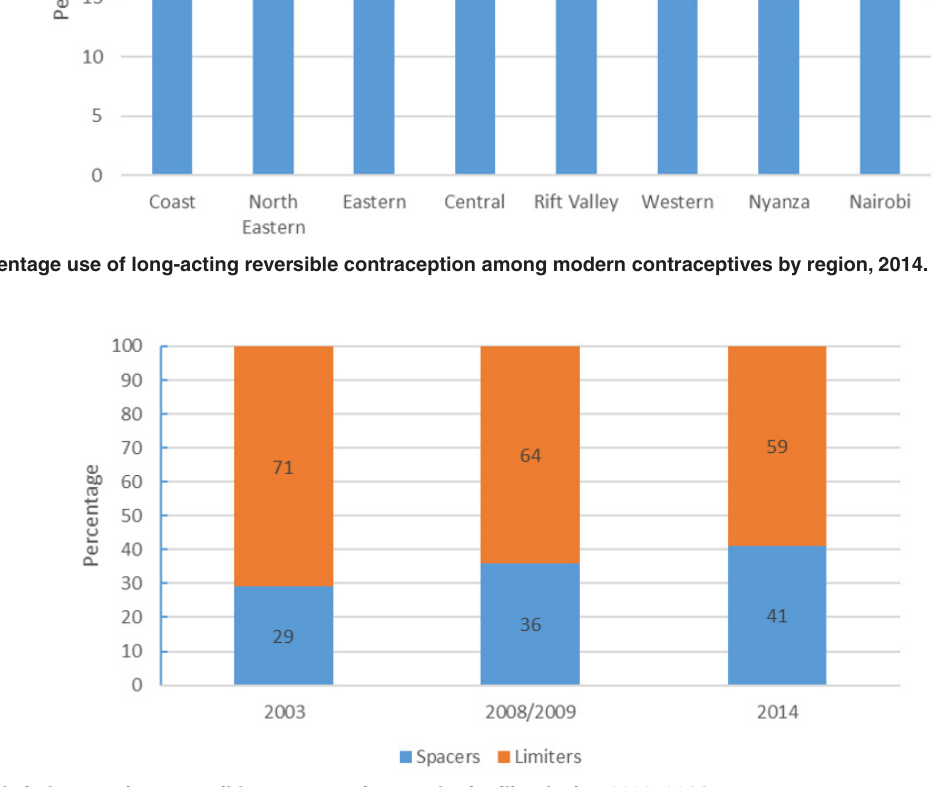
Figure 9. Trends in long-acting reversible contraception use by fertility desire,